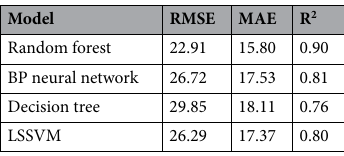
Table 6. Model prediction accuracy evaluation.